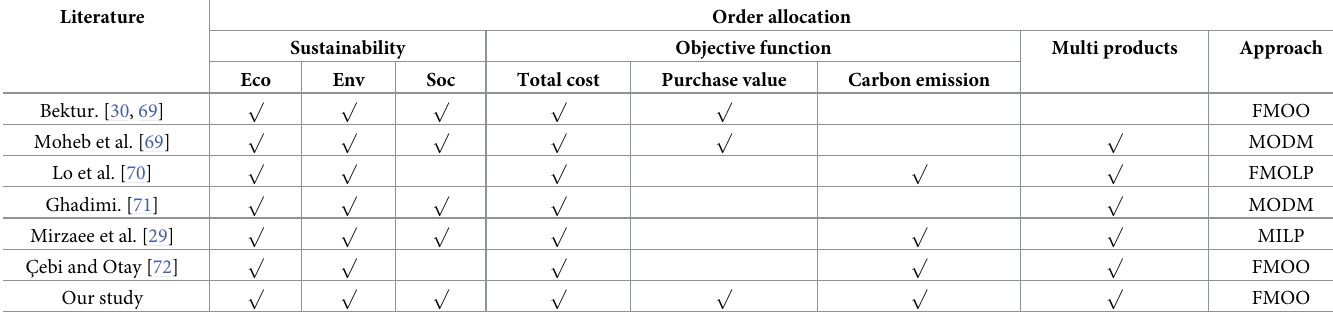
Table 18. Qualitative comparison of MCGDM techniques.